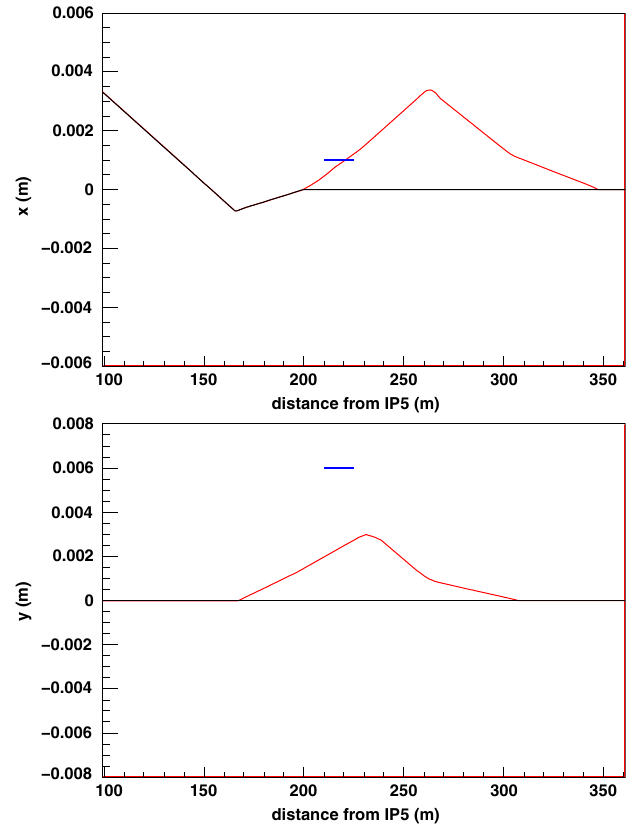
FIG. 15. (Color) The formation of horizontal and vertical local closed bumps across the TOTEM 220 m station. The available correctors can make a dangerous horizontal bump, but not a vertical bump. The black line shows the ideal orbit, the red line shows the bumped orbit, and the blue line denotes the physical boundary of the TOTEM